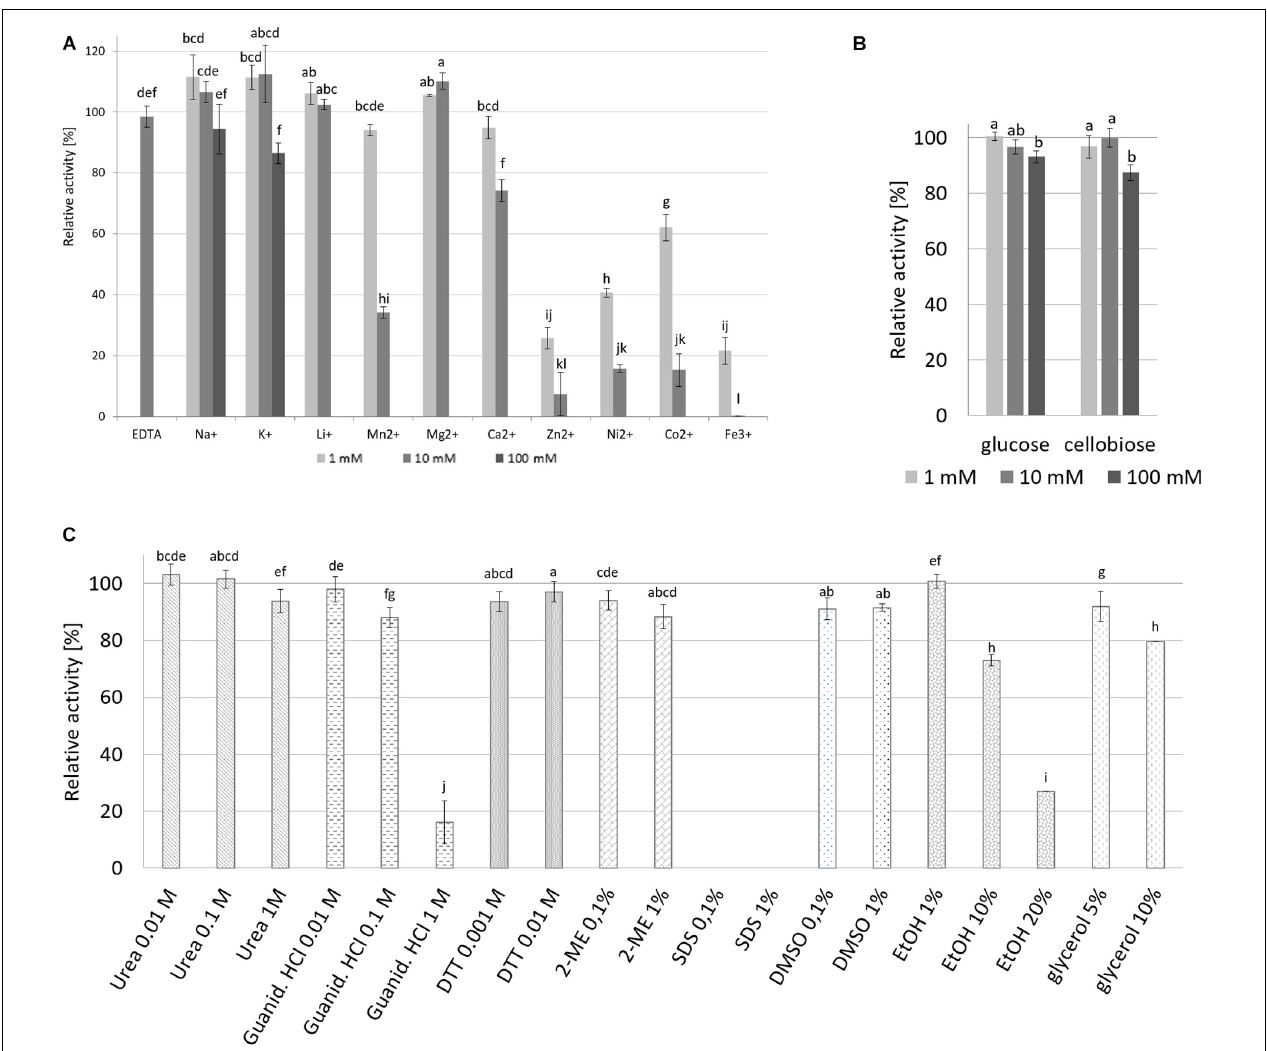
FIGURE 9 | The effect of metals, sugars and various chemical agents on recombinant CelRH5 activity. (A) Influence of EDTA and metal ions on the CelRH5 activity. (B) Influence of glucose and cellobiose on the CelRH5 activity. (C) Influence of selected reagents on the CelRH5 activity. Control activity is sample without addition of reagents representing 100%. The error bars represent the standard deviation ( n = 3) and different letters mean statistically significant